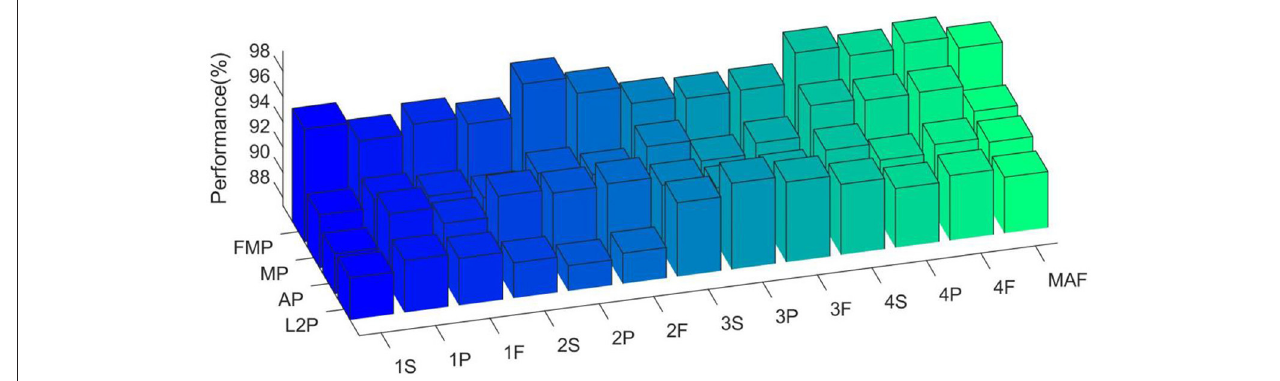
FIGURE 11 | A 3D bar plot of SPNN vs. other pooling methods.